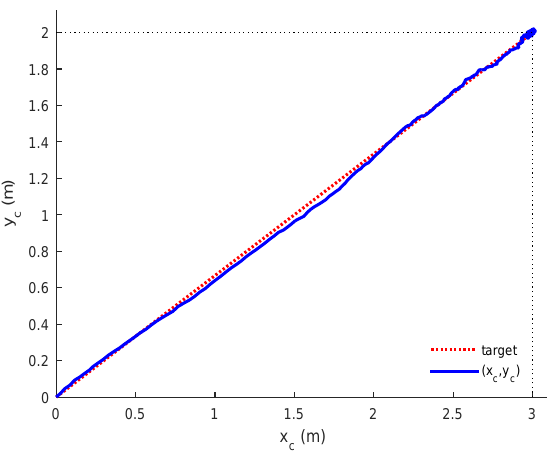
Figure 9. The trajectory coordinates of the OMR.